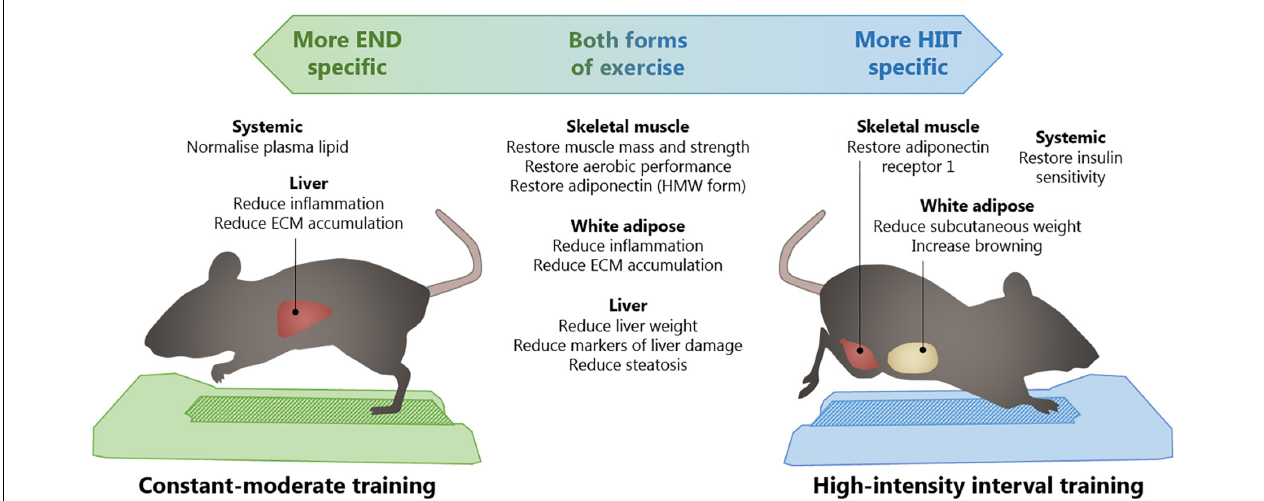
FIGURE 12 | Summary of proposed clinical implications of different exercise programs in the normalization of outcomes of high-fat diet. Across the two running subjects, common benefits of constant-moderate endurance (END) and high-intensity interval training in skeletal muscle, subcutaneous adipose tissue, and liver, are listed. On the left, specific putative benefits from END are described and, on the right, benefits specific to HIIT are listed. High molecular weight (HMW); extracellular matrix